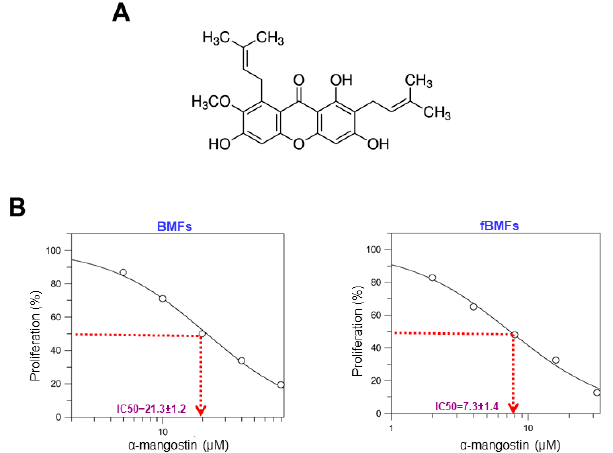
Figure 1. α -mangostin inhibited the proliferation rate of fBMFs without causing damage to normal BMFs . ( A ) The chemical structure of α -mangostin. ( B ) The cytotoxicity effect of α -mangostin in normal buccal mucosal fibroblasts (BMFs) and fibrotic BMFs (fBMFs). Cell survival/viability of BMFs (left panel) and fBMFs (right panel) were determined by MTT assay. IC 50 values were calculated by GraFit software.